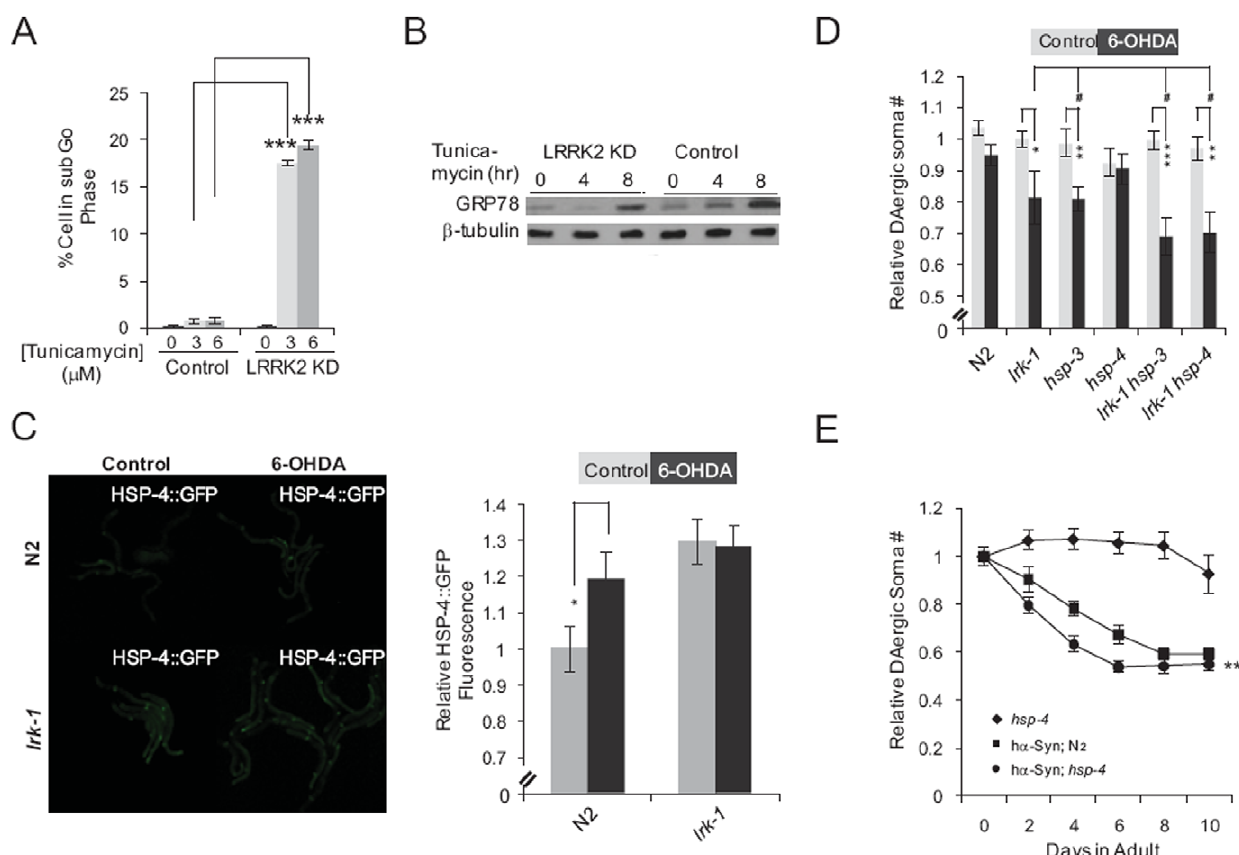
Figure 5. LRRK2 supports GRP78-mediated cell survival. ( A ) Quantification of the populations of cells with sub-G0 DNA content in cultures of SH-SY5Y cells transfected with a control vector (Control) and MIX LRRK2 KD SH-SY5Y cells (LRRK2 KD) treated with 0, 3 or 6 m M tunicamycin for 16 hours. Data represent the mean 6 SEM of 3 independent experiments. ***, p , 0.005 by t-test. ( B ) Tunicamycin-induced upregulation of GRP78 is compromised in LRRK2 KD cells. SH-SY5Y cells transfected with a control vector (Control) and MIX LRRK2 KD SH-SY5Y cells (LRRK2 KD) were treated with 3 m M tunicamycin for the indicated periods of time. Cell lysates were prepared and analyzed by Western blotting with antibodies against GRP78 and b -tubulin (loading control). ( C ) 6-OHDA induced HSP-4::GFP upregulation in N2, but not in the lrk-1 mutant. L3 animals were treated with 2 mM 6-OHDA or vehicle alone (Control) for 1 h. Twenty-four hrs later, these animals were immobilized on 2% agarose pads with 3 mM sodium azide and then examined under a Leica DMI3000 microscope. HSP-4::GFP fluorescence of each animal was quantified as described in Experimental Procedures. Data represent the mean 6 SEM. Each experiment employed 20 nematodes. *, p , 0.05 by t-test. ( D ) Day 6 aniamls of the indicated genotypes were treated with vehicle alone (Control) or 2 mM 6-OHDA (6-OHDA) for 1 h at L3. DAergic neurons were counted and normalized as described in Experimental Procedures. Data represent the mean 6 SEM of three independent experiments. Each experiment employed 20–30 nematodes. # , p . 0.05 by one-way ANOVA with Bonferroni correction, and *, p , 0.05; **, p , 0.01; ***, P , 0.005 by t-test. ( E ) HSP-4 protects h a Syn-induced DAergic neuron degeneration in C. elegans . Quantification of h a Syn-induced DAergic neuron degeneration as a function of age in N2 (squares) and loss-of-function hsp-4 mutant nematodes (circles). An hsp-4 nematode line expressing only DsRed served as a control (diamonds). DAergic neuron somas of hermaphrodites were counted on the indicated days and normalized to the mean number of DAergic somas observed in respective L4 nematode larvae as described in Experimental Procedures. Data represent the mean 6 SEM of three independent experiments. Each experiment employed 40–60 nematodes. **, p , 0.01 by two-way ANOVA, testing samples between hsp-4 and N2 nematodes expressing h a Syn.